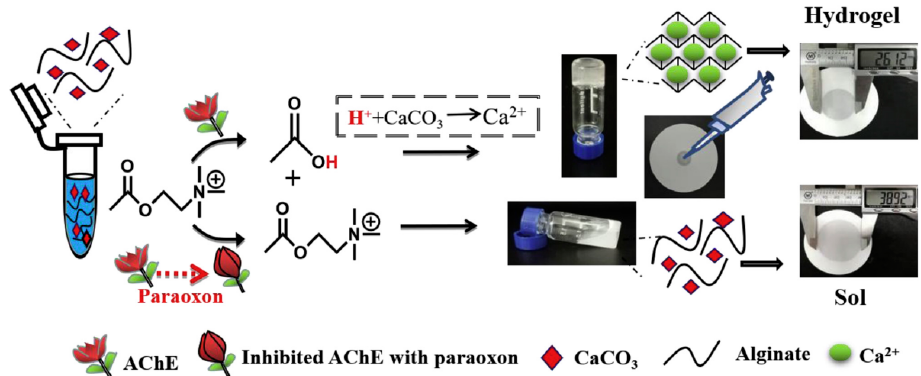
Figure 10. Schematic illustration of paper-based sensors with pH-responsive alginate hydrogels and the analytical strategy for the detection of OPs. Reproduced with permission from Jia Xu, Analytica Chimica Acta; published by Elsevier, 2019.